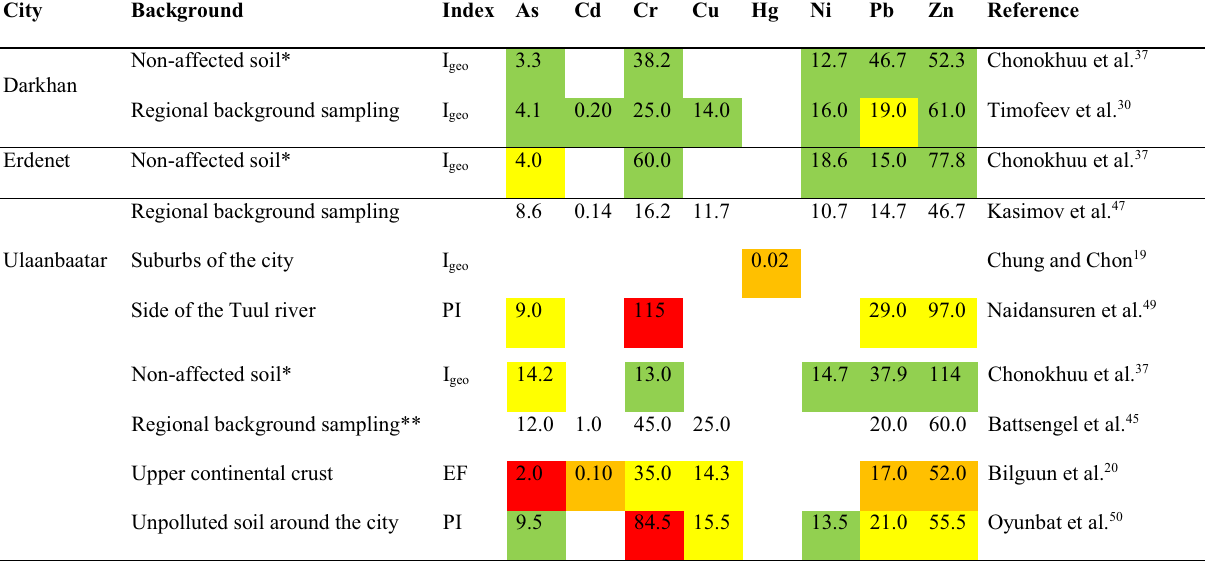
Table 4. Background values (mg/kg) used in the studies on urban soil pollution in Mongolia together with generalised level of contamination/pollution calculated based on these background values (where clearly indicated). Colours signals "contamination/pollution" level found/indicated in the respective study: green = none, yellow = low/minor, orange = moderate, red = high/heavy; I geo = geoaccumulation index, EF enrichment factor, PI pollution index. *Based on the references (local studies) and the composition of the continental crust. **Cited from the local source studying background concentration of microelements in Ulaanbaatar’s regional natural surface